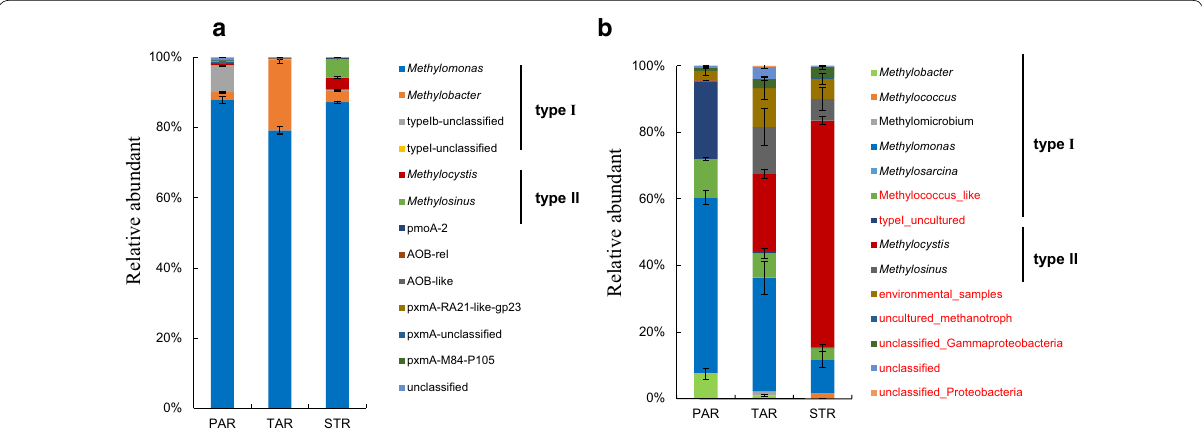
Fig. 2 Relative abundant of aerobic methanotroph community structure in different emergent plants at the genus level based on DNA ( a ) and cDNA ( b ) analysis of pmo A (PAR, P. australis root; TAR, T. angustifolia root; STR, S. triqueter